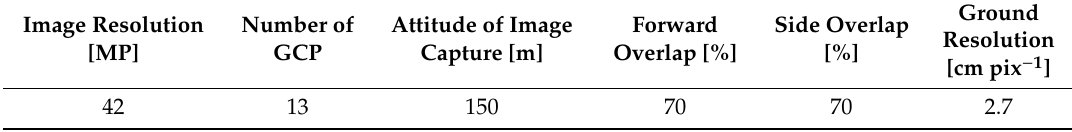
Table 3. Unmanned aerial vehicle (UAV) data survey